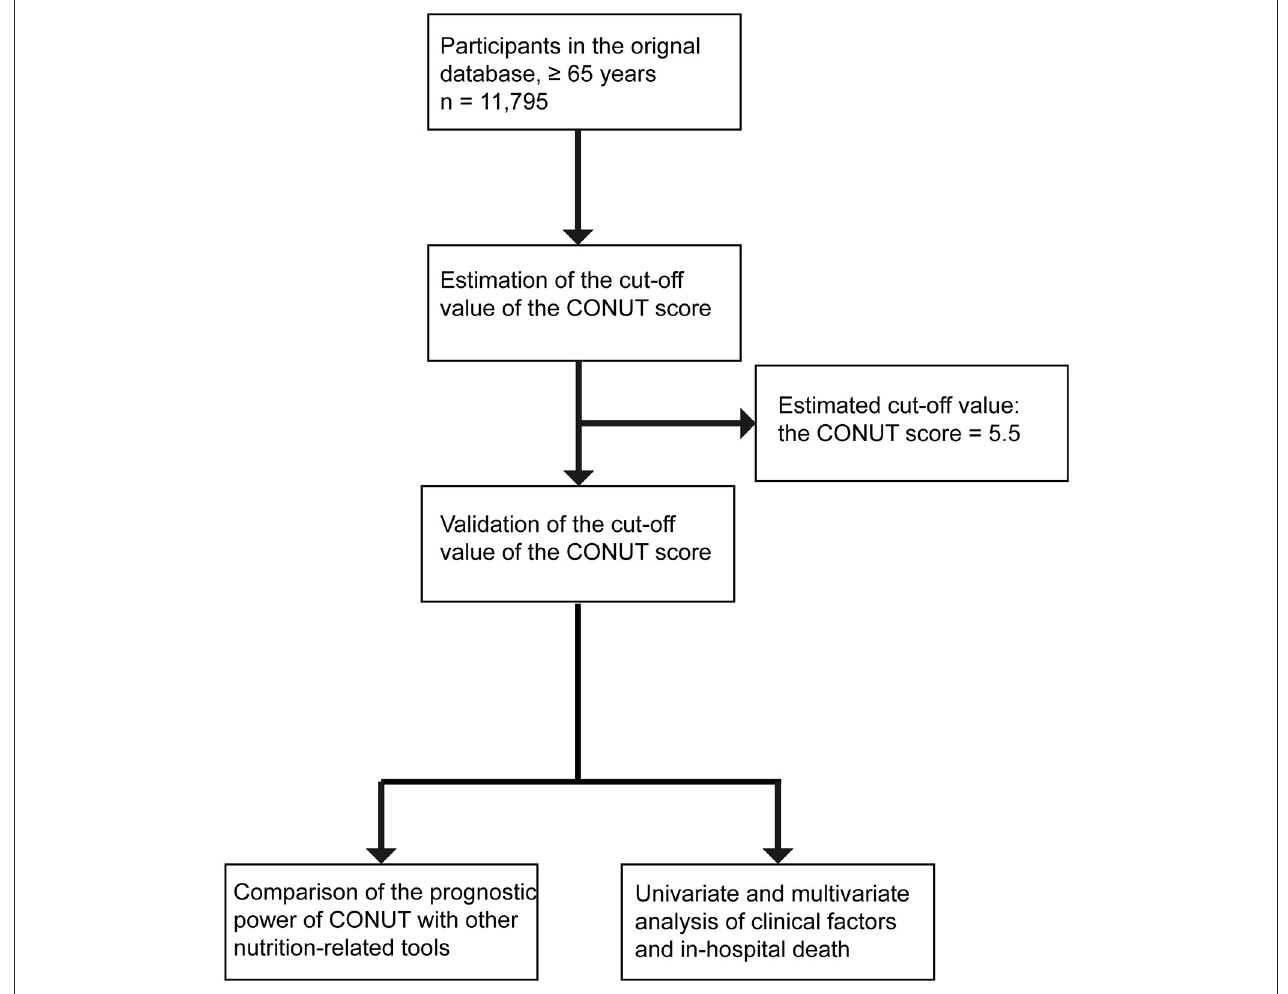
FIGURE 1 | Flow chart of the